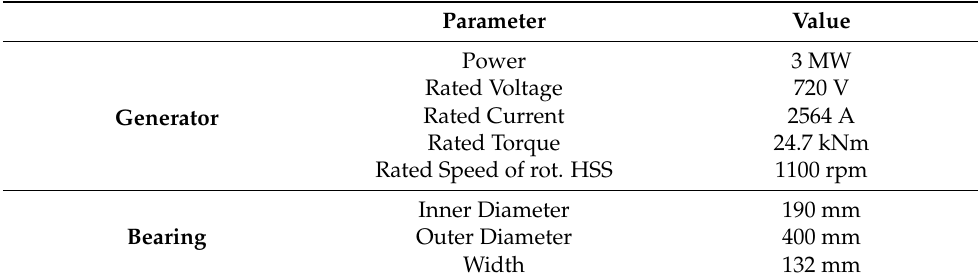
Table 1. Parameters of the generator and the